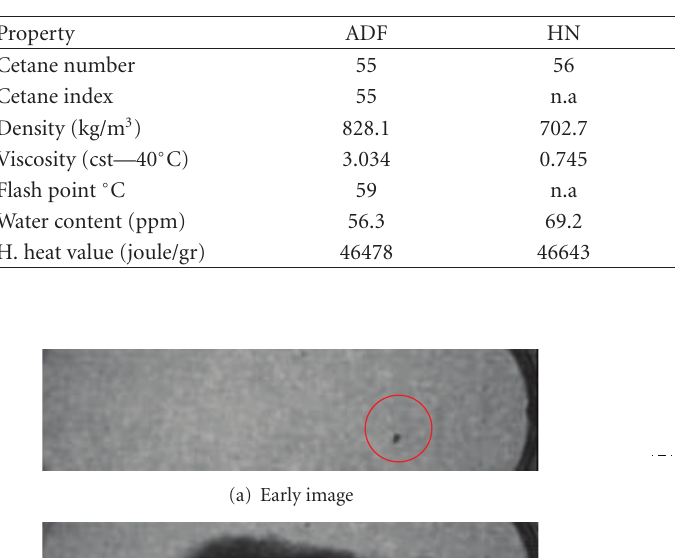
Table 2: Fuel properties of the tested fuels.